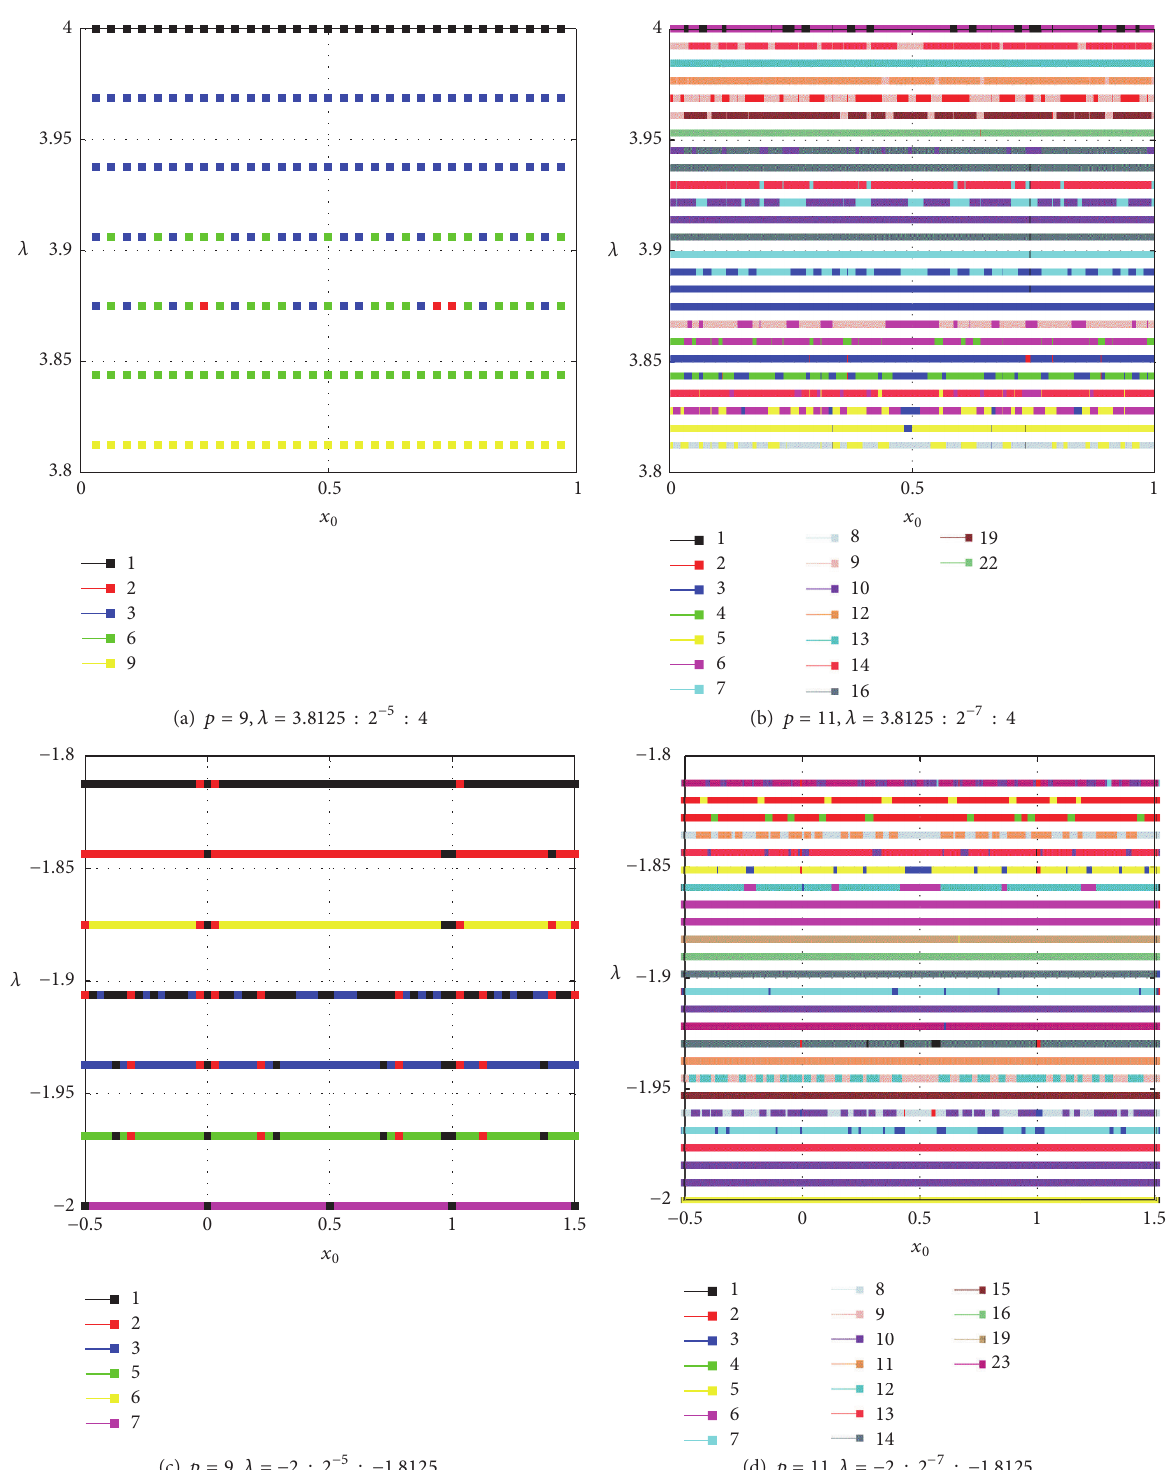
Figure 15: All the generated period lengths in the studied ranges of parameter 𝜆 and all initial points allowed by 𝑝 for 𝑓 3 (𝑥) and different